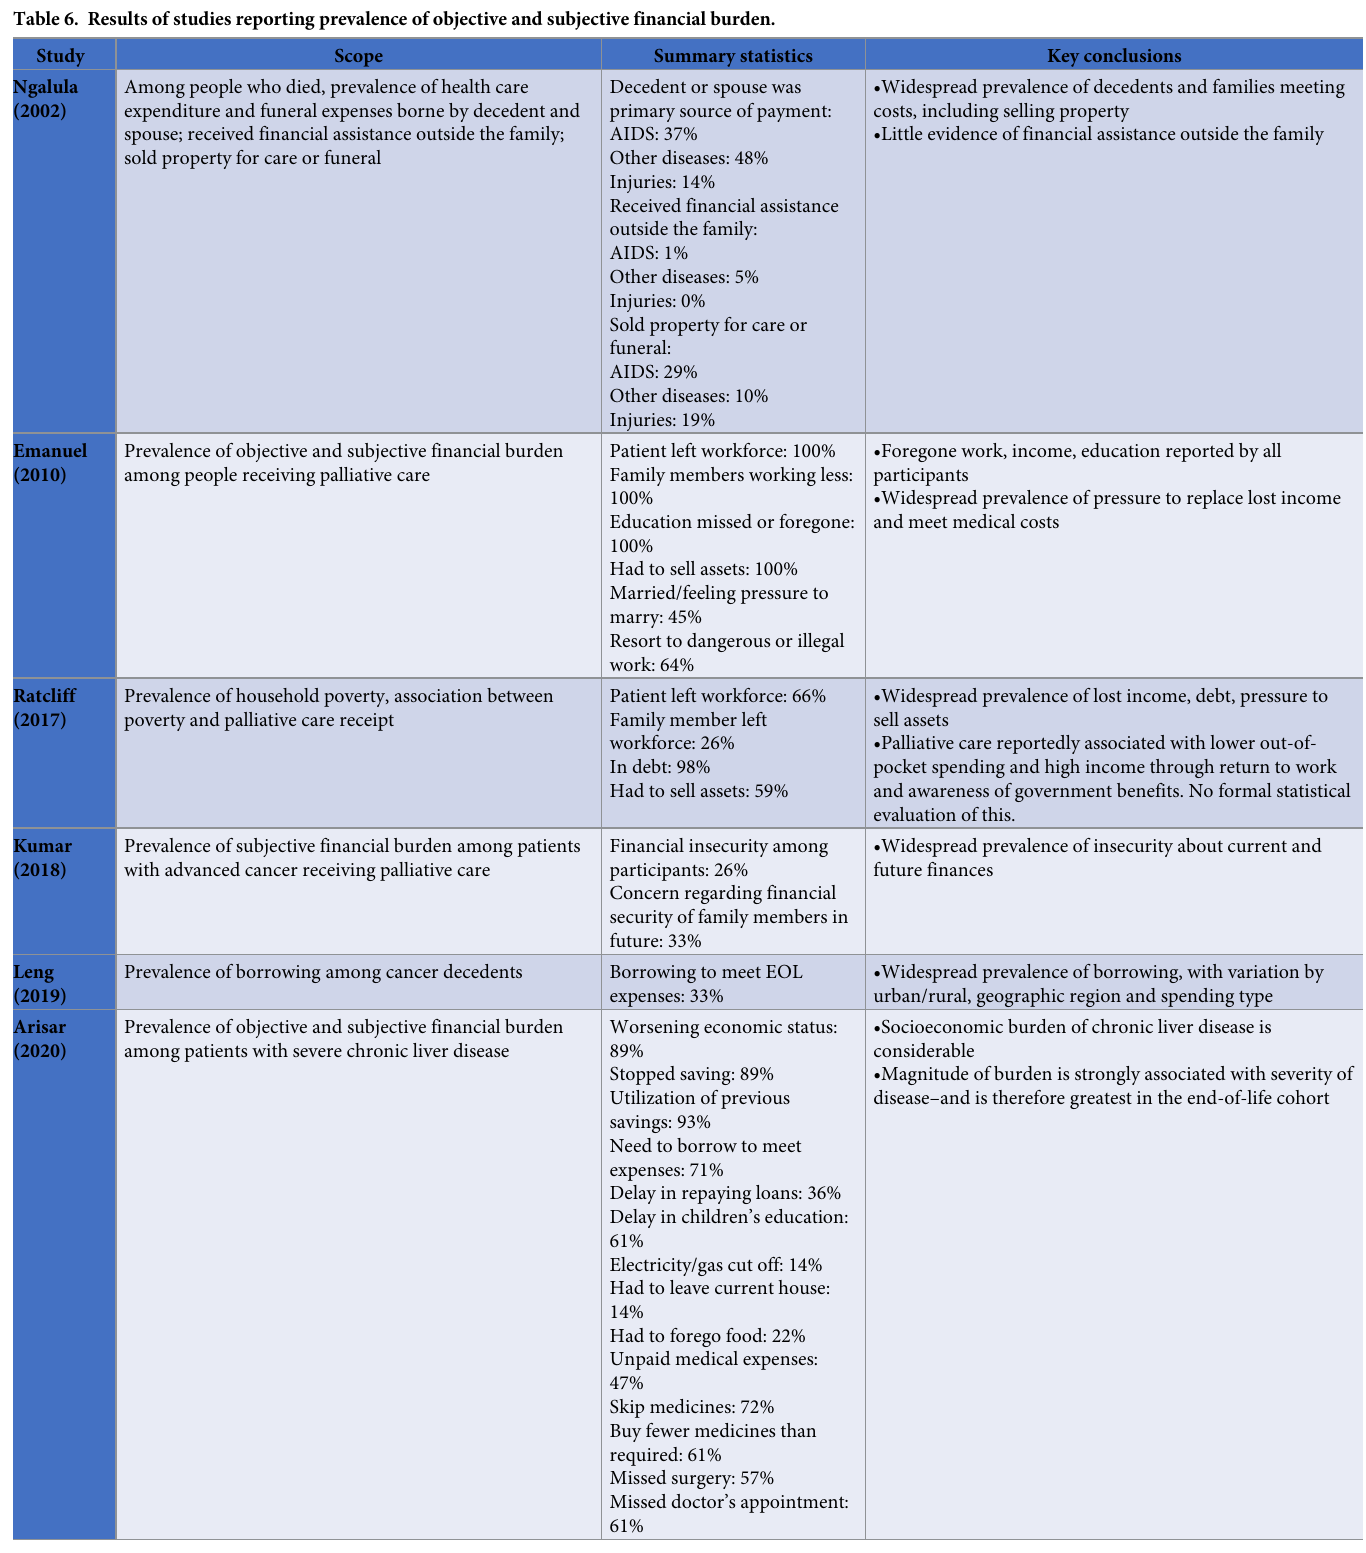
Table 6. Results of studies reporting prevalence of objective and subjective financial burden.